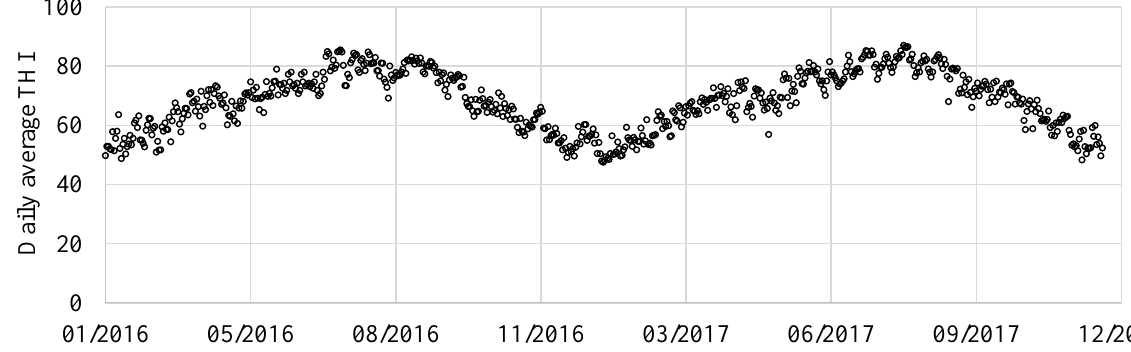
Figure 2. Barn indoor THI values calculated for the years 2016 – 2017 considered in the